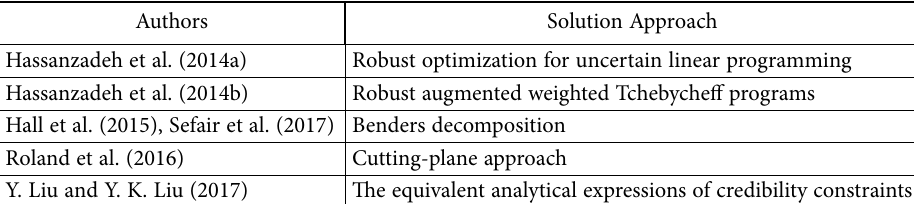
Table 14. Exact approaches applied in